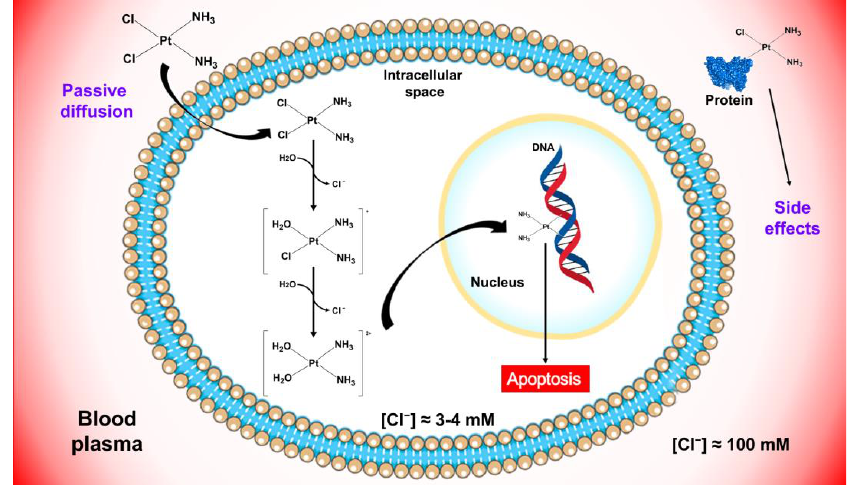
Figure 3. Schematic representation of cisplatin mechanism of action.